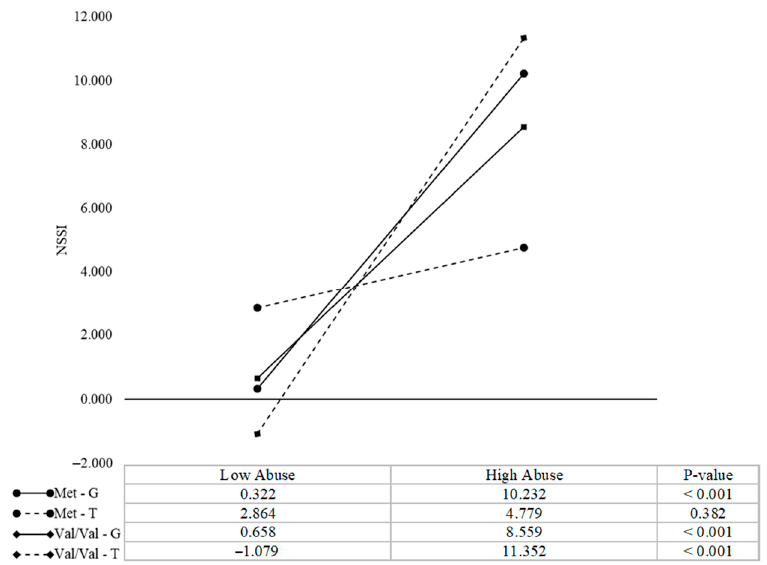
Figure 1. Interaction among MAOA T941G, COMT Val158Met, and child abuse associated with adolescent boys’ nonsuicidal self-injury (NSSI). High and low abuses are defined as +/ − one standard deviation from the mean, respectively. All continuous values were mean-centered.